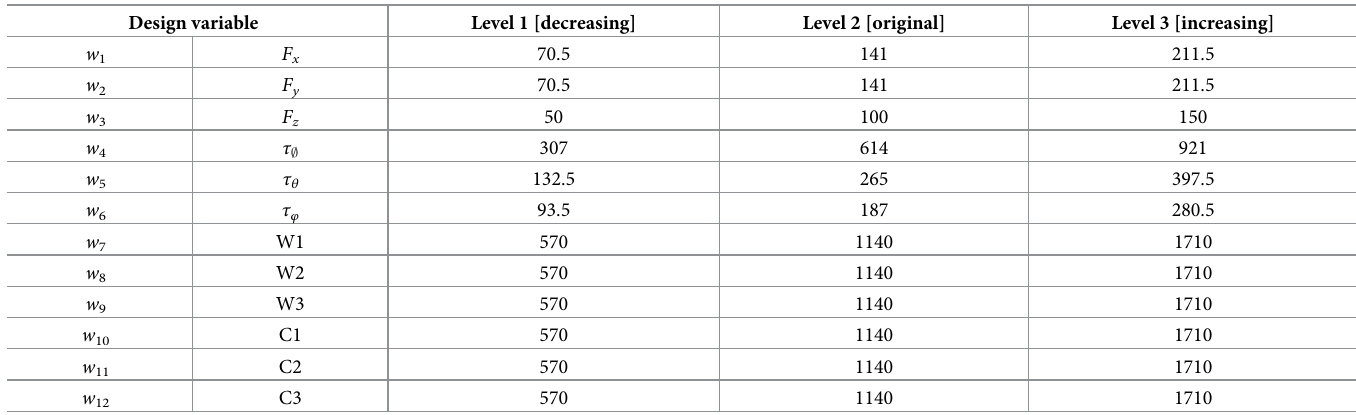
Table 4. Set initial value and initial stage of weighting matrix. Design